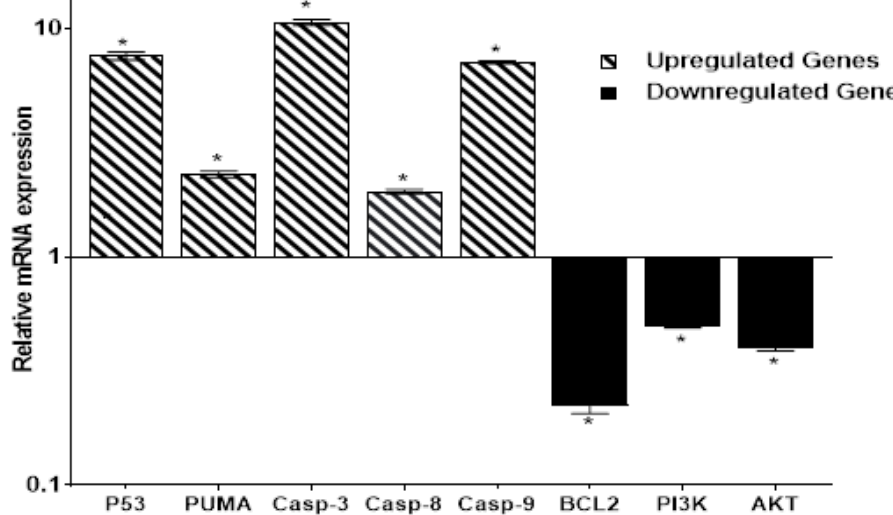
Figure 5. Gene expression of apoptotic-related genes in control and treated HepG2 cells with compound 4 (IC 50 = 0.017 µ M) using RT-PCR. Untreated control is represented by a black line (Fold change = 1). Values are represented by mean ± SE ( n = 3 independent sample per group). * Significant difference between control and treated groups using an unpaired Student’s t -test ( p ≤ 0.05) using SPSS Version 22.